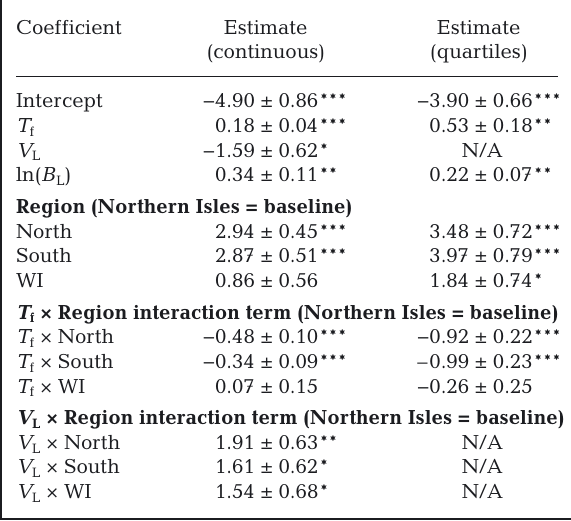
Table 1. Model coefficients using continuous (left column) or quantised (quartiles; right column) data (±1 SE). The optimal quantised model excludes loch volume, and so its sig ni - ficance and regional interactions are not applicable (N/A). T f = loch flushing time; V L : loch volume; B L : loch biomass; WI: Western Isles. Statistical significance: *0.01 < p ≤